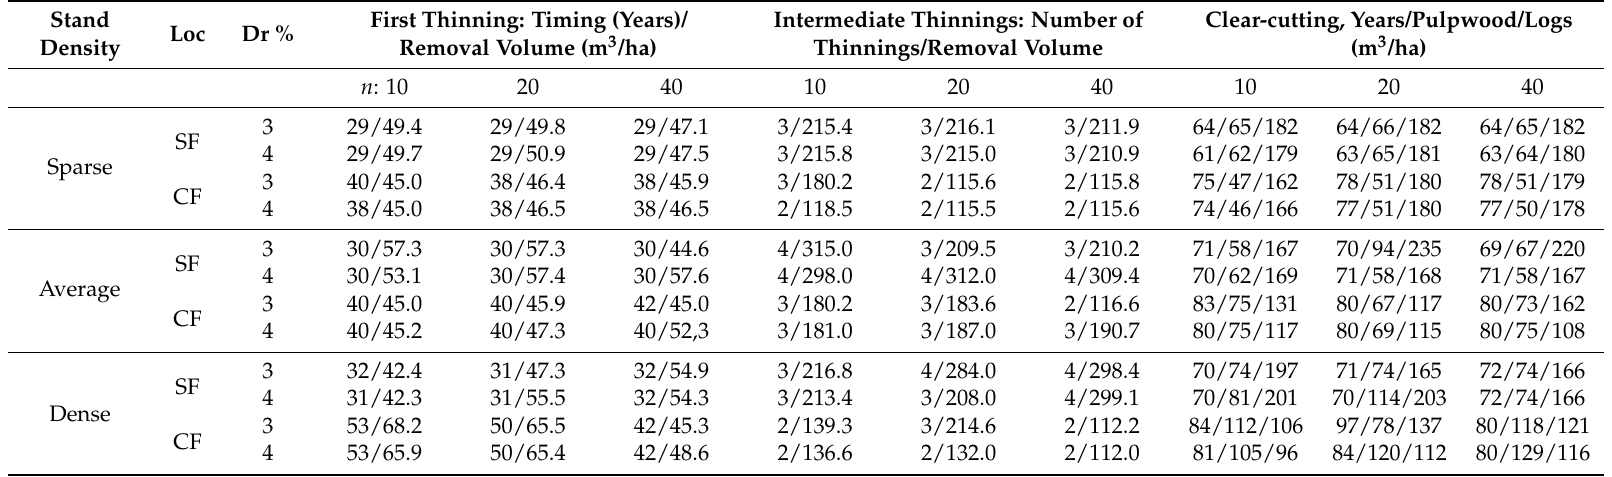
Table 2. Thinning characteristics and rotation periods associated with the optimal solutions. The location (Loc) was in southern Finland (SF) or central Finland (CF). The discount rate (Dr) was expressed in